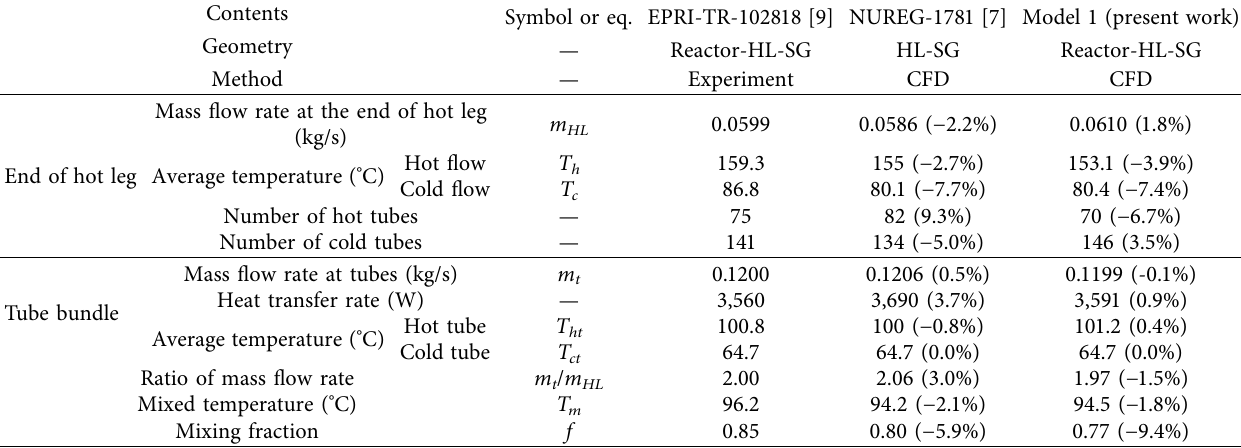
Table 2: Comparison of the main evaluation factors between previous studies and CFD analysis.